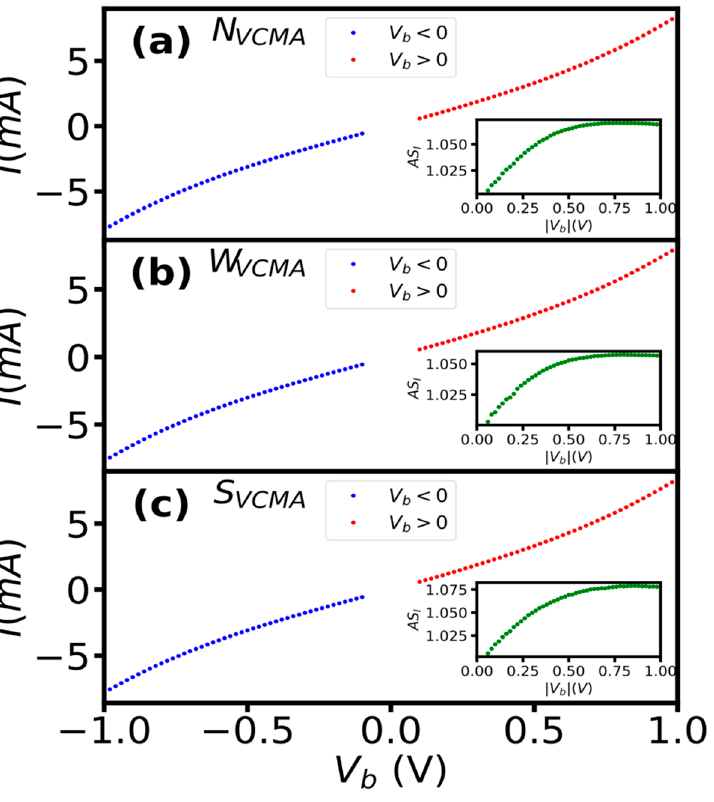
Figure 3. The influence of bias polarity on current and its symmetry (inset) of sensors without ( a ), with medium ( b ) and strong ( c ) VCMA modification. The asymmetry was computed as AS I = I(+V b )/I( − V b ).